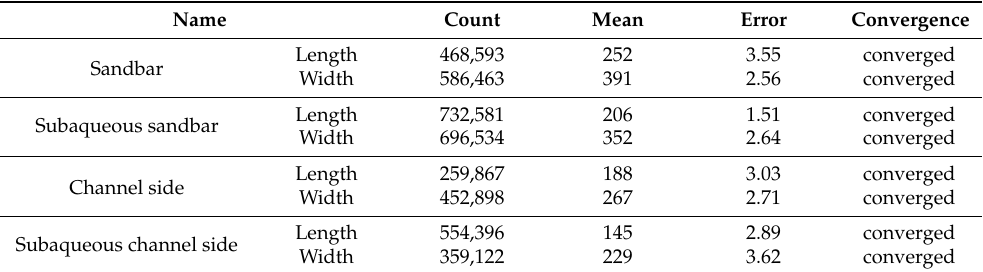
Table 7. Statistics of simulation